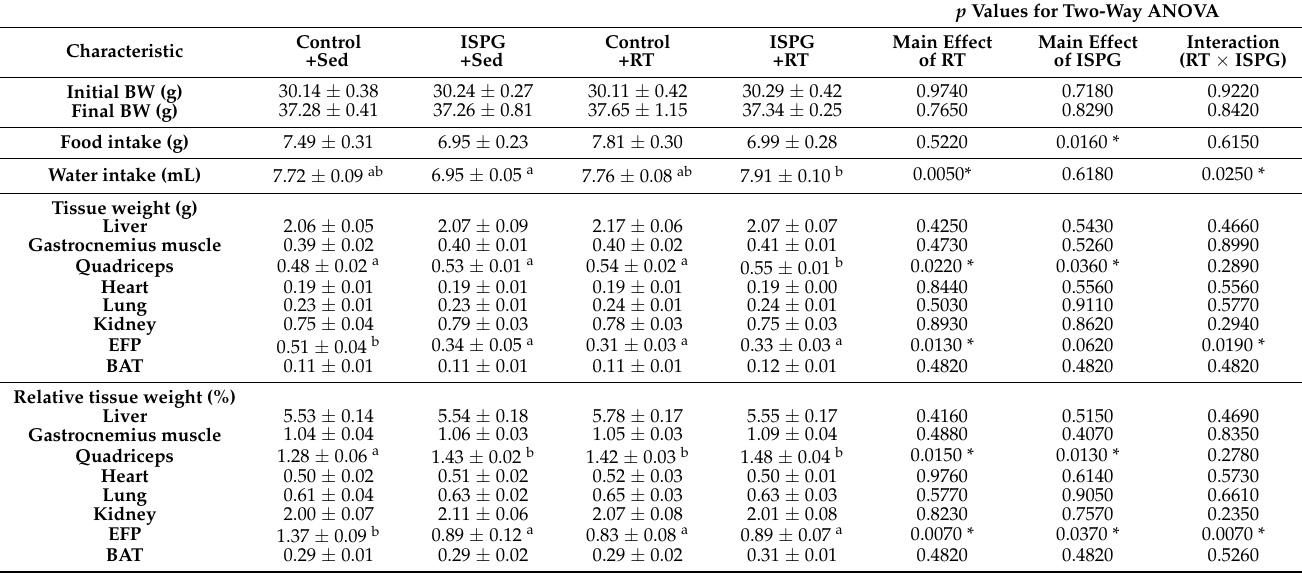
p Values for Two-Way ANOVA